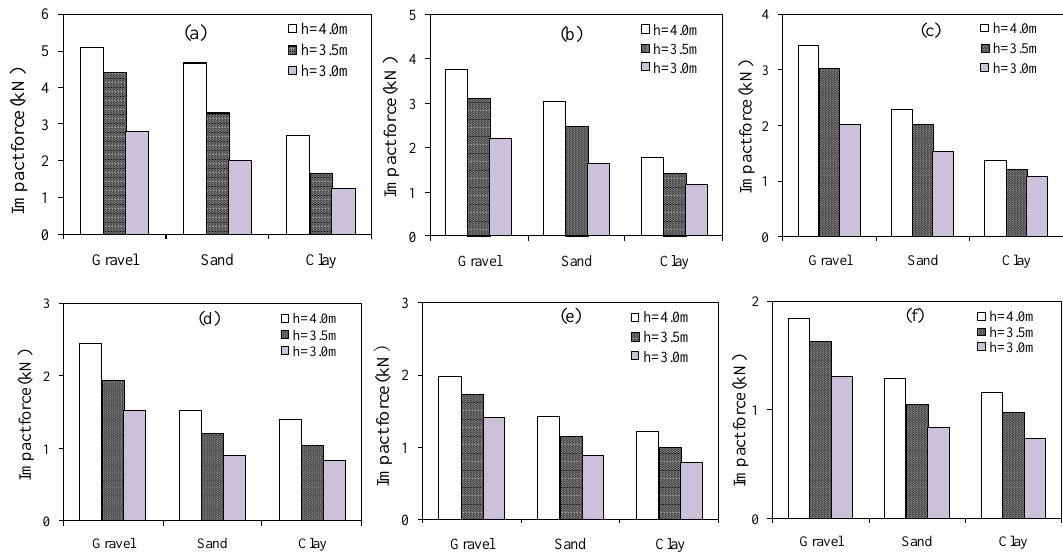
Figure 8. Influence of cushion layer on the impact force: (a) incident angle α = 90 ◦ , thickness of cushion layer t = 2cm; (b) α = 60 ◦ , t = 2cm; (c) α = 30 ◦ , t = 2cm; (d) α = 90 ◦ , t = 4cm; (e) α = 60 ◦ , t = 4cm; and (f) α = 30 ◦ , t = 4cm.